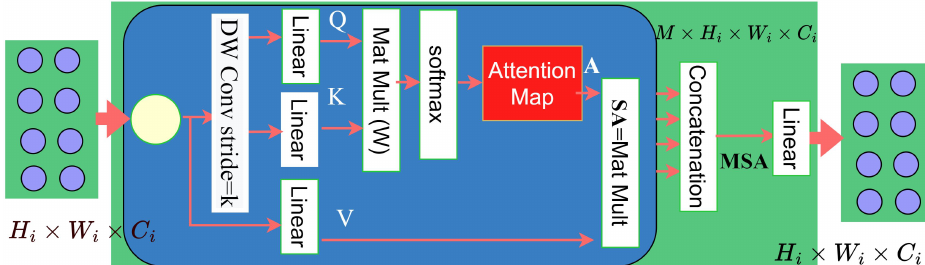
Figure 4. Lightweight multi-head